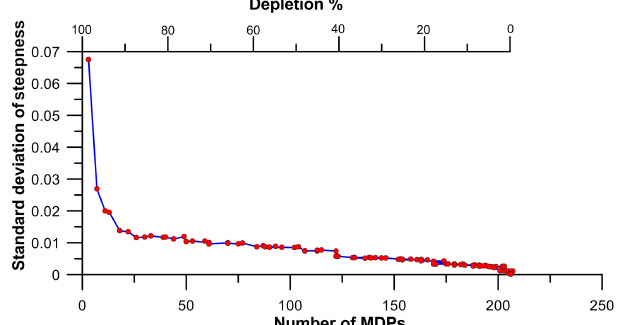
Figure 8. Application of the depletion test to the macroseismic field of the 20 May 2012 earthquake (Figs. 1, 2; ID 13 in Table 1) taken from the HSIT database (available at https://e.hsit.it/772691/index. html, last access: 22 December 2022), for which there exist 207 MDPs falling within a radius of 55km from the epicenter. The per- centage of MDPs falling within each ring-shaped area (see Fig. 1) was gradually depleted from 1% to 99%, and the steepness was calculated 1000 times for all the different depleted datasets. So a total of 100000 calculations were done. The y axis shows the vari- ability in the calculated steepness, expressed through the standard deviation of the steepness obtained for the depleted datasets with the same number of MDPs.